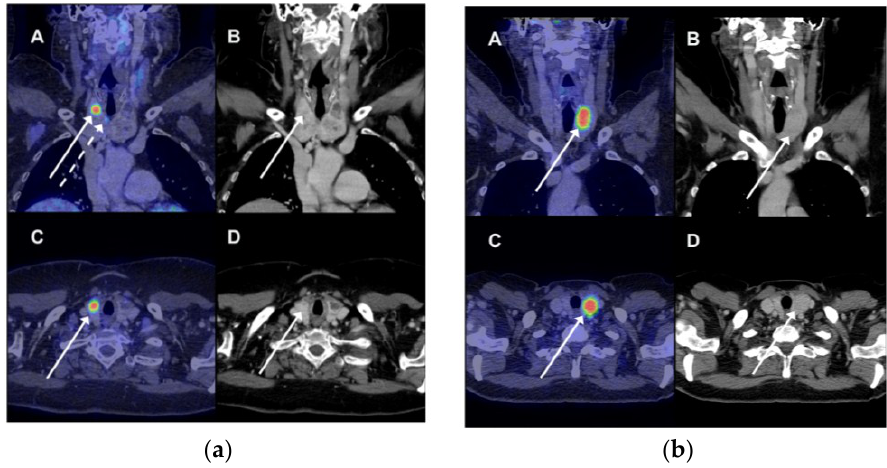
Figure 1. ( a ) A 69-year woman had a 18F-fluorodeoxyglucose positron emission tomography/computer tomography (FDG PET/CT) scan because of suspected pancreatic cancer (not verified). There was incidental FDG uptake in three lesions in the right thyroid. The patient underwent total thyroidectomy; pathology showed papillary adenocarcinoma in all three PET-avid lesions. (A) Fused coronal PET/CT images showed intense FDG uptake (standardized uptake value, SUV 9.8) in the upper right part of the right thyroid (full white arrow). Another site of pathological FDG uptake was seen on this coronal slice as well (dotted white arrow). (B) The CT image showing a bilateral nodular goiter with an arrow indicating the site of most intense FDG uptake on the fused images. (C + D) Corresponding transverse images of the fused PET/CT images and CT scan with the most intense FDG-avid lesion; ( b ) An FDG PET/CT was performed in a 69-year woman due to suspicion of ovarian cancer (confirmed). Incidental FDG uptake was seen in the left lobe. A fine needle aspirate showed benign findings (colloid nodule). Any false-negative findings were ruled out during clinical and imaging follow. (A) Fused coronal PET/CT images showed intense FDG uptake (SUV 11.0) in the upper right part of the right thyroid (full white arrow). (B) The CT image showing a bilateral nodular goiter with an arrow indicating the most intense site of pathological FDG uptake on the fused images. (C + D). Corresponding transverse images of the fused PET/CT images and CT scan of the most intense FDG-avid lesion.